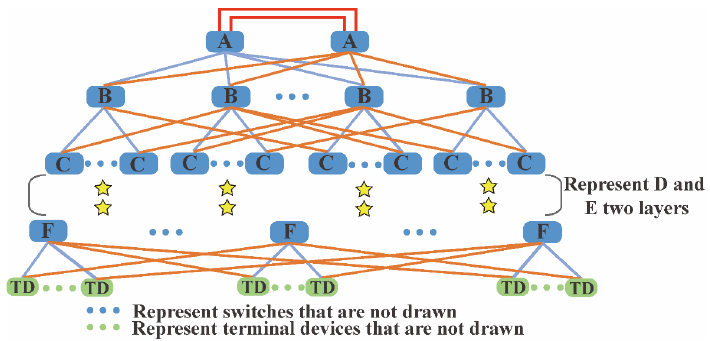
Figure 2. Schematic diagram of the novel redundancy topology architecture.